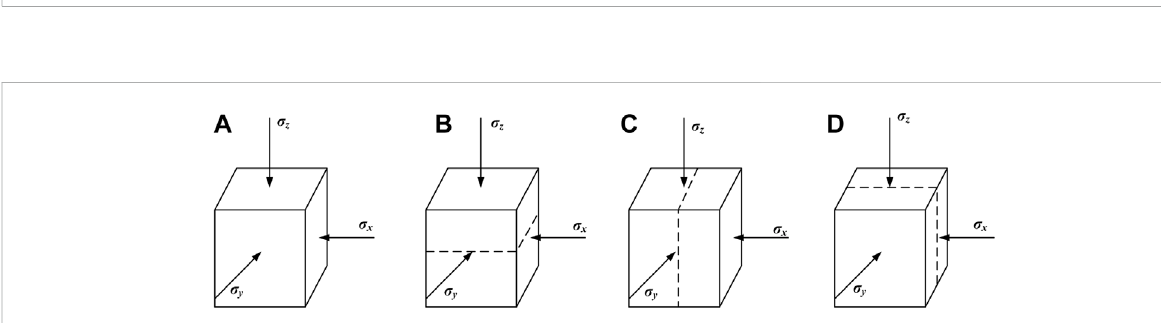
FIGURE 7 Relationship between stress and fracture morphology. (A) Three-dimensional stress state. (B) When σ z is the minimum principal stress, horizontal fractures are formed. (C) When σ x is the minimum principal stress, fractures perpendicular to σ x are formed. (D) When σ y is the minimum principal stress, fractures perpendicular to σ y are